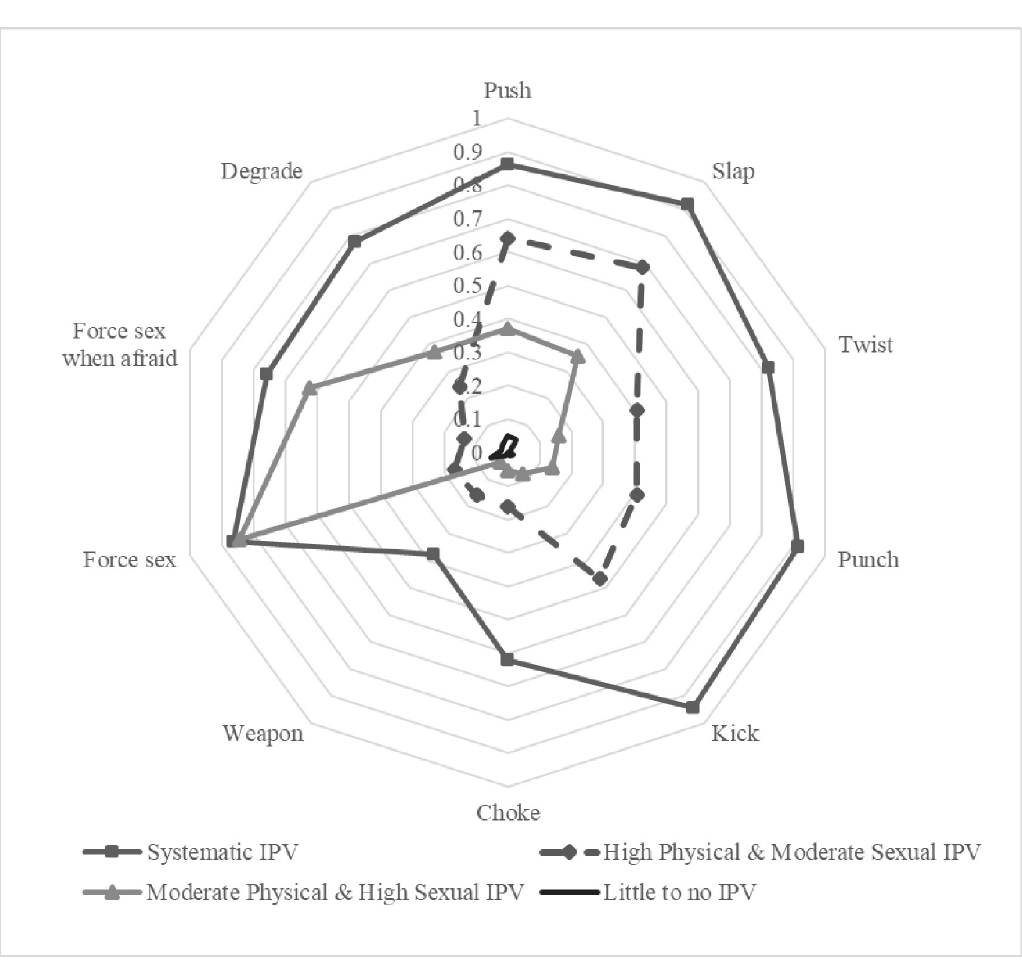
Fig 1. Conditional item probability plot.